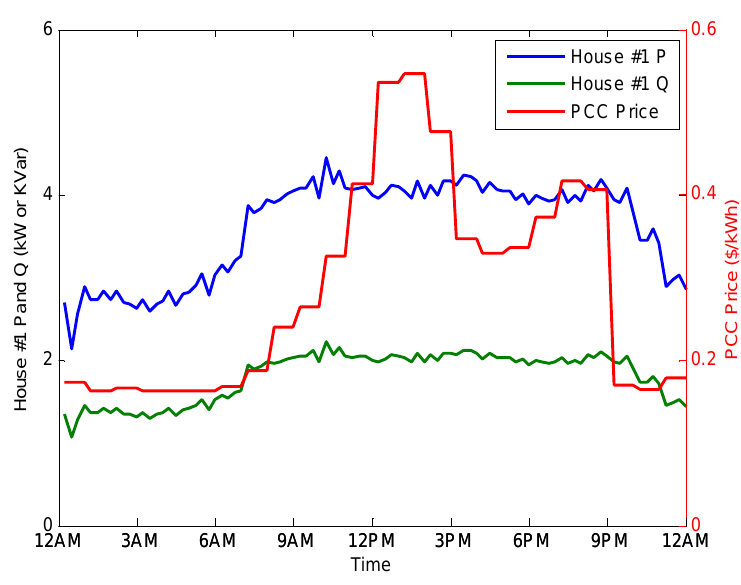
Figure 4. Non-HVAC demand in house and electricity price at the PCC.